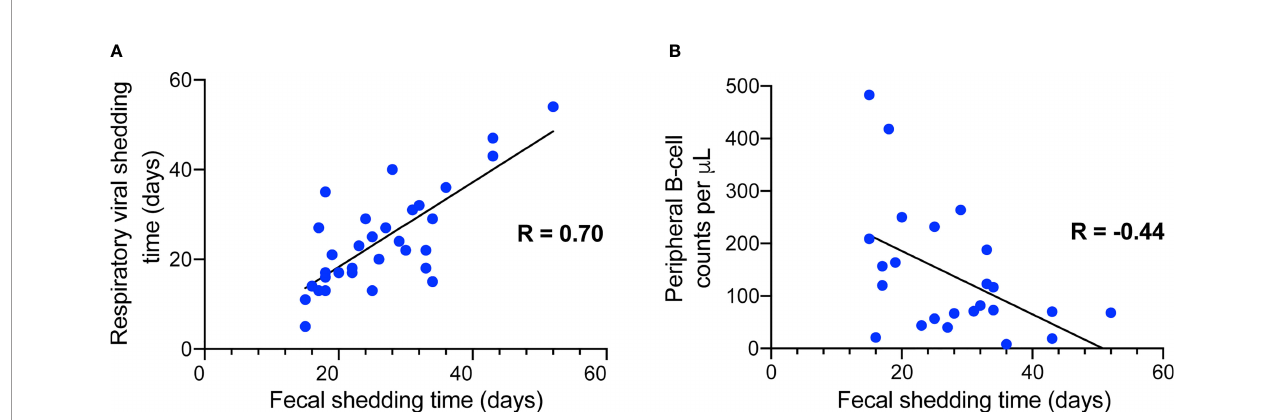
FIGURE 1 | Correlation analysis between fecal shedding duration and respiratory shedding duration (A) as well as plasma B-cell counts (B)